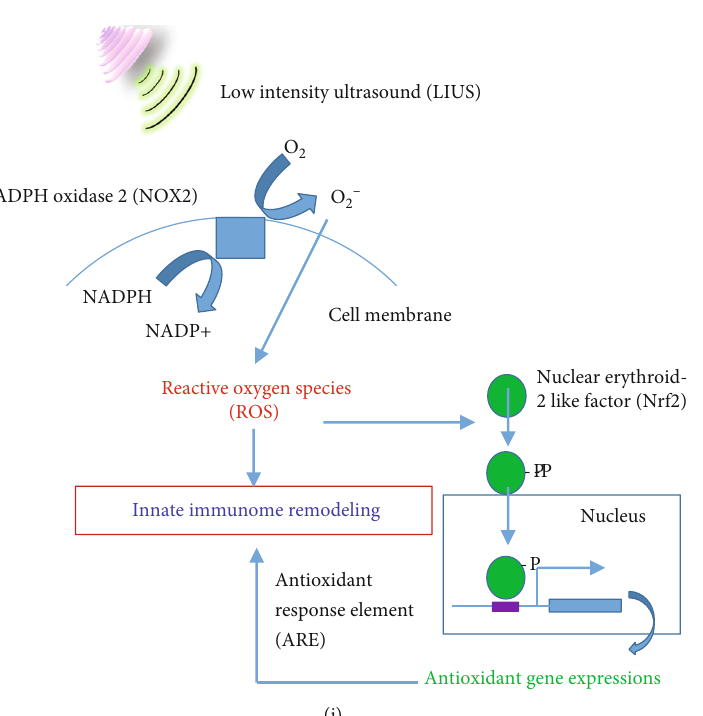
Figure 9: (a) LIUS modulates oxidative stress-related gene expressions (reactive oxygen species, ROS, and regulatome). Three out of a total of 84 (3.70%) oxidative stress genes (ROS regulatome) were upregulated in lymphoma cells (L) and bone marrow cells (B). Gpx3 was shared in L and B. Two out of a total of 84 genes (2.47%) were downregulated in bone marrow cells (B). No oxidative stress gene expressions were changed in the preosteoblast microarray dataset. (b) LIUS modulates the ROS regulatome in a cell-speci fi c manner. (c) The Ingenuity Pathway Analyses (IPA) of ROS dependence to LIUS-modulated innatomic genes in three types of cells were summarized into four groups: (1) the ROS-promoted group, (2) the ROS-suppressed group, (3) the ROS-dependent/suppressed pathway-uncertain group, and (4) the ROS-independent group. These results demonstrated that LIUS-modulated innatomic genes were signi fi cantly mediated by ROS- promoted or ROS-suppressed pathways in bone marrow cells, which were higher than those of LIUS-modulated innatomic genes in lymphoma cells. In addition, the IPA-identi fi ed signi fi cant pathway numbers in bone marrow cells that were signi fi cantly higher than those of lymphoma cells, suggesting that ROS-modulated genes in lymphoma cells are much more diversi fi ed in the pathways than those of bone marrow cells (see supplemental Tables 17A-17F for details). (d) LIUS-modulated innatomic genes were classi fi ed into four groups, namely, (1) the ROS-promoted group, (2) the ROS-suppressed group, (3) the uncertain (not shown) group, and (4) the ROS-independent group, based on their expression changes in ROS-generating enzyme NOX2 KO microarrays and antioxidant transcription factor Nrf2 KO microarrays. (e) Six ROS-promoted pathways were involved in LIUS-upregulated genes in bone marrow cells. (f) Three ROS-suppressed pathways were involved in LIUS-upregulated genes in bone marrow cells. (g) The top 10 of a total of 31 ROS-promoted pathways were involved in LIUS-downregulated genes in bone marrow cells. (h) Only one ROS-suppressed pathway was involved in LIUS-downregulated genes in bone marrow cells. (I) Only one ROS-suppressed pathway was involved in LIUS-upregulated genes in lymphoma cells. (j) LIUS modulates innatome via reactive oxygen species (ROS) pathways mediated by pro-ROS generation enzyme nicotinamide adenine dinucleotide phosphate (NADPH) oxidase 2 (NOX2) (PMIDs: 21629295; 28916473) and antioxidant transcription factor nuclear erythroid-2 like factor (Nrf2) (PMID: